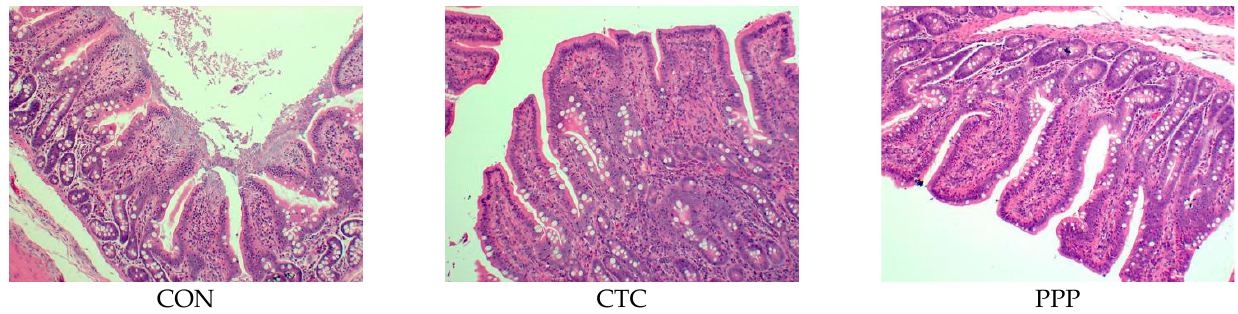
Figure 1. Dietary pomelo peel powder affected ileum morphology in weaned piglets.